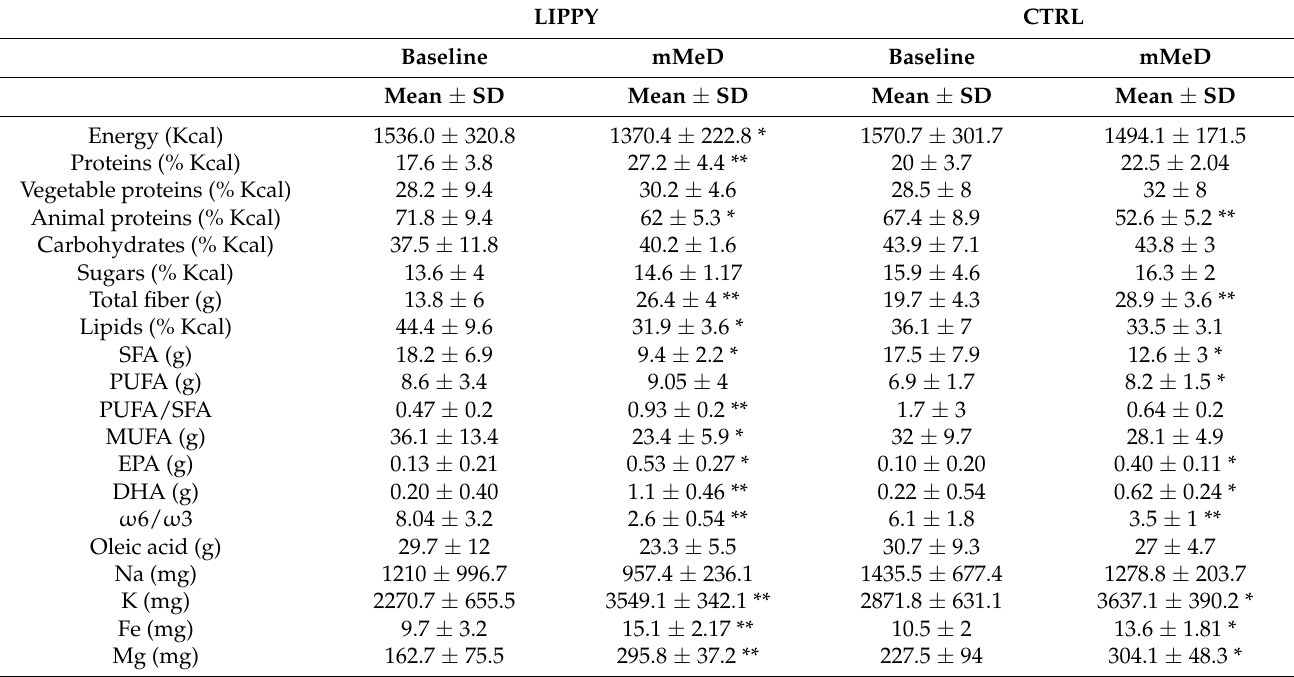
Table 1. Dietary components (macro- and micronutrients) and nutritional indexes of the mMeD with respect to the baseline diet. LIPPY